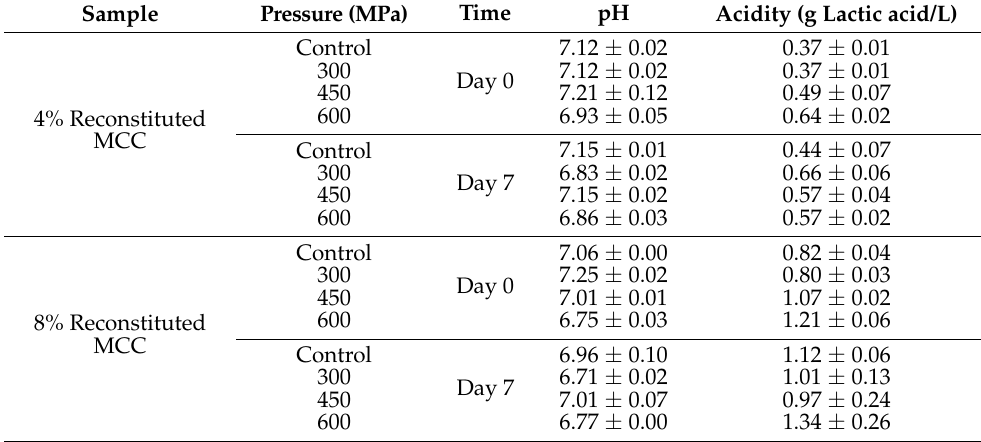
Table 5. pH and acidity of pressurized reconstituted micellar casein concentrate during storage at 10 ◦ C